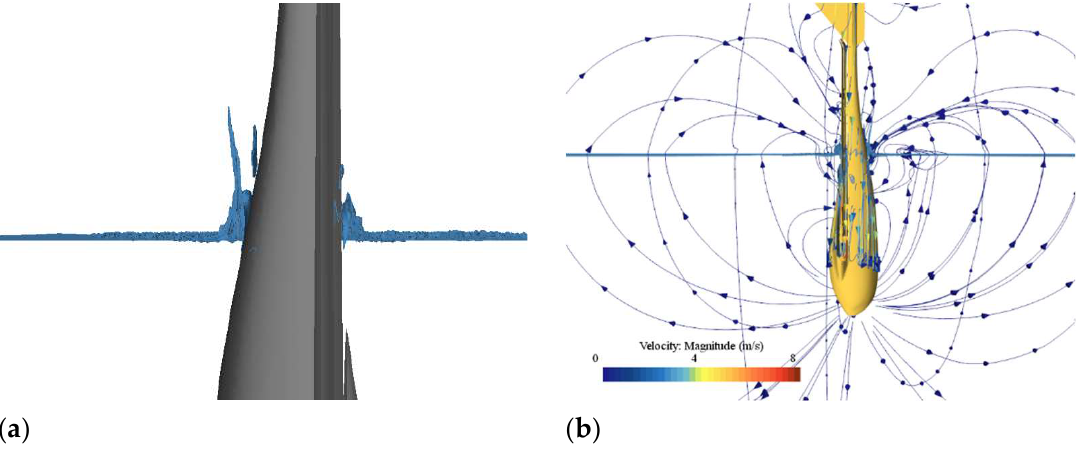
Figure 10. Profiles for ( a ) jet flow and ( b ) streamlines around the UAUV with W s = 4.0 m/s at t = 0.15 s. The characteristics of the predicted vertical velocity, acceleration, and hydrodynamic force are analyzed against a submergence parameter s . The depths curves of the vertical translation s and vertical velocity (in the Earth-fixed coordinate) are given in Figure 11a,b. While impacting the water, the vehicle decelerates due to the slamming force exerted on it. Through the comparison of different W s , it was found that vertical translation varies faster with larger vertical velocity.